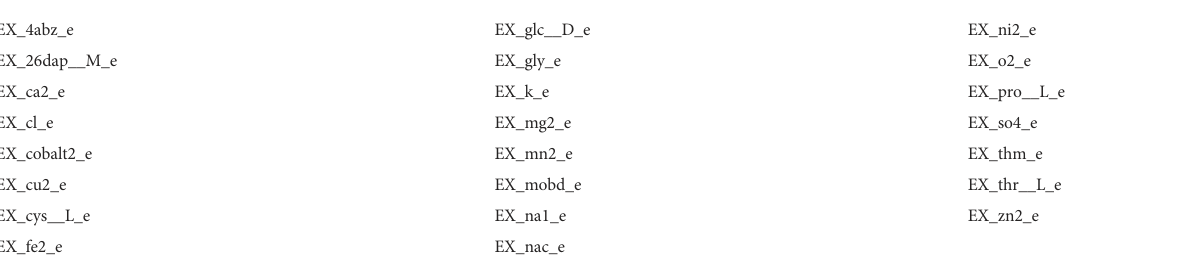
TABLE 3 COOPM computed for D. pigrum and S. aureus . Exchange reactions computed in COOPM medium for D. pigrum and S.